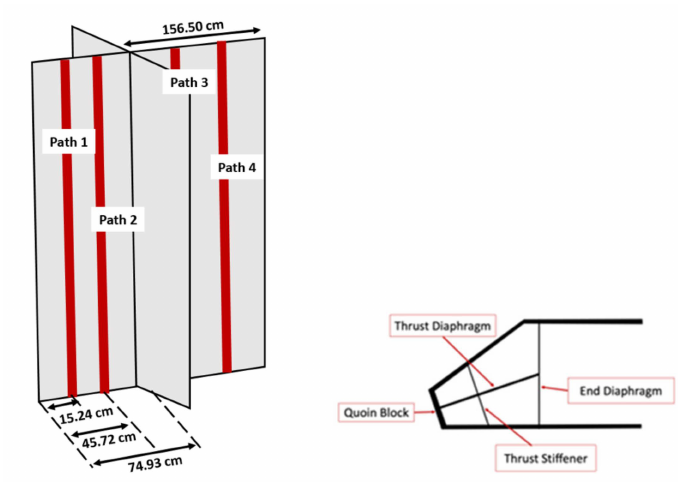
Figure 11. Vertical stress paths along the thrust diaphragm.